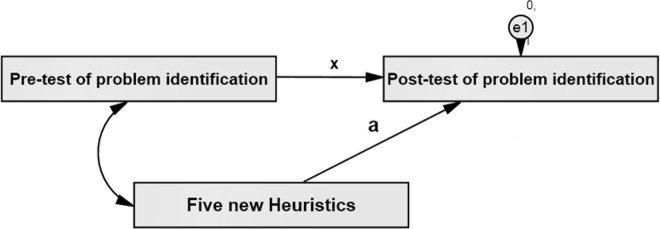
Hypothesis model.